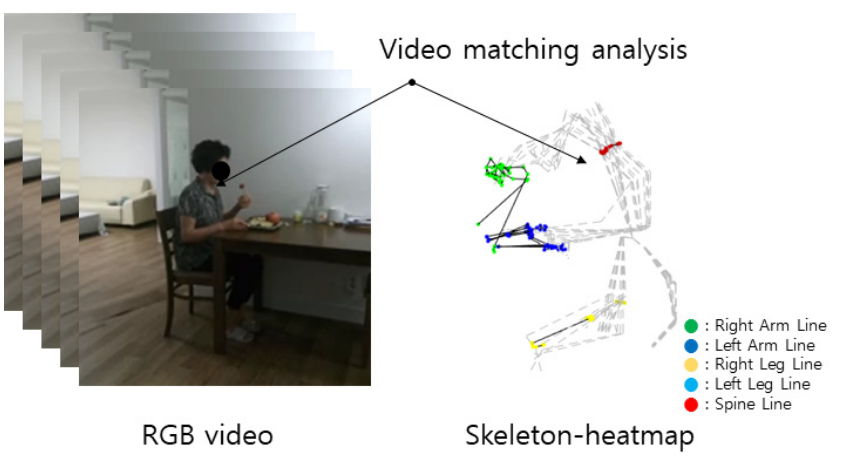
Figure 7. Video matching analysis of the skeleton-heatmap for the behavior of an elderly person eating fruits with a fork.